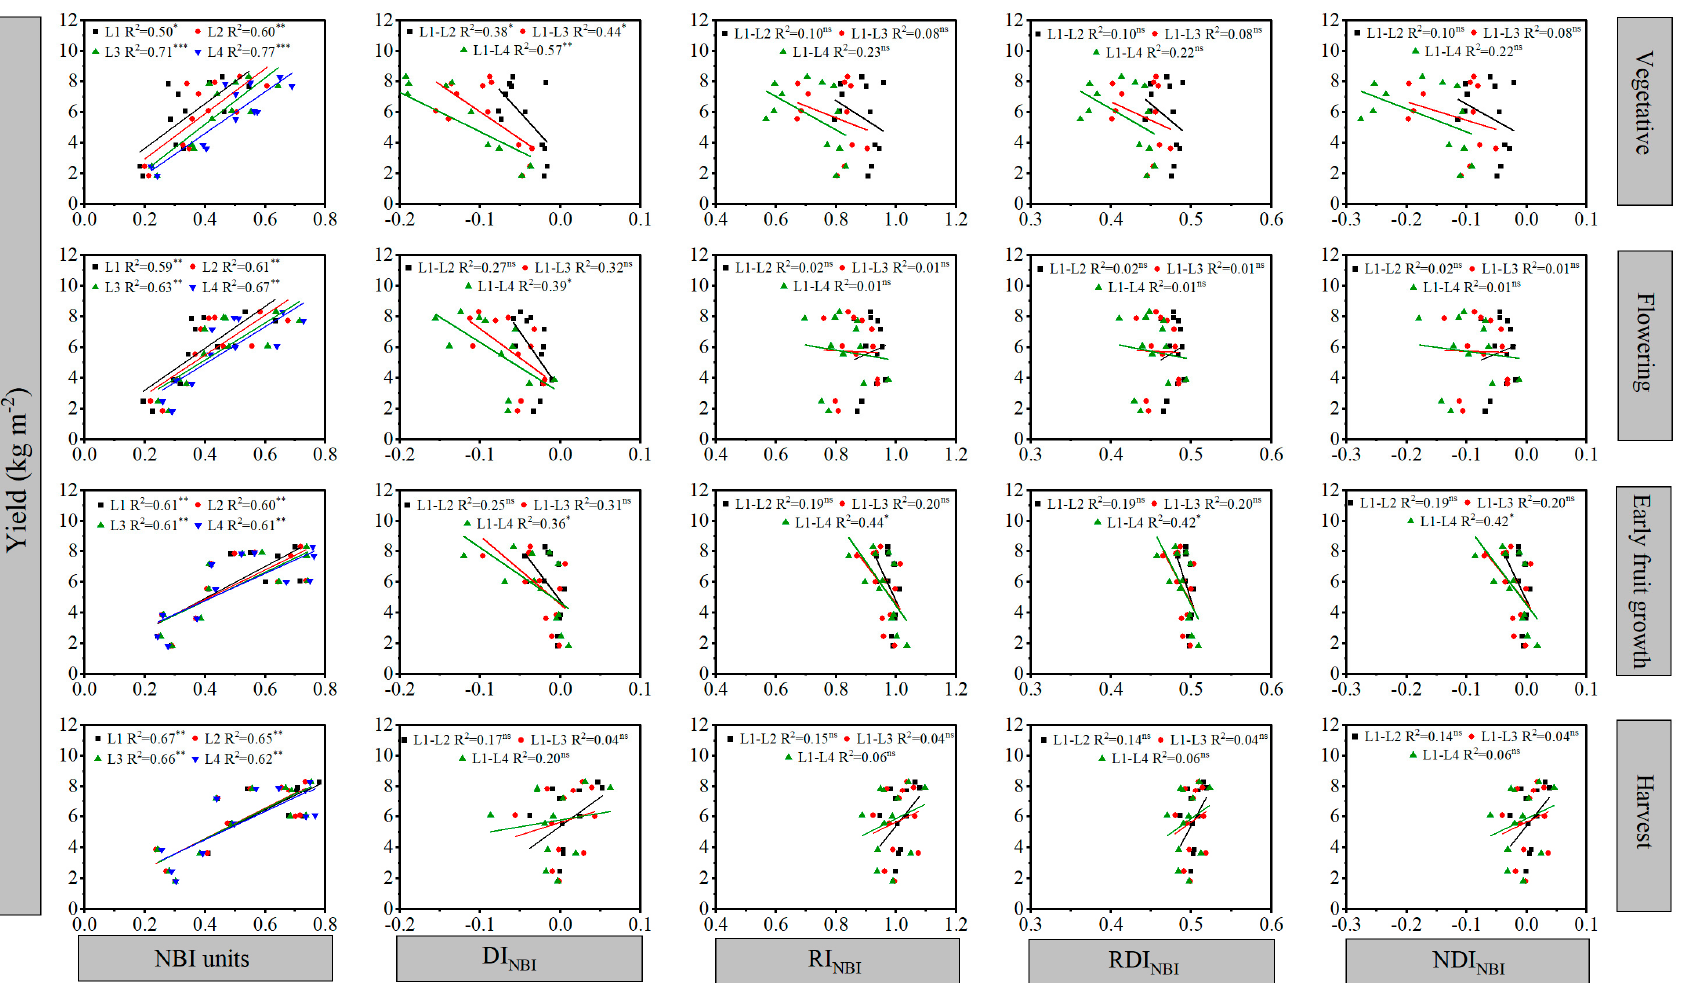
Figure 5. The relationships between absolute NBI measurements and several normalized NBI indices (DI, RI, RDI, NDI) with total fruit yield (kg m − 2 ) at different phenological stages of muskmelon, for calibration data. L1, L2, L3 and L4, refer to the latest (most recent) second, third and fourth fully expanded leaf, respectively. Asterisks show significance of regressions: ***, p < 0.001; **, p < 0.01; *, p < 0.05; ns, p > 0.05.